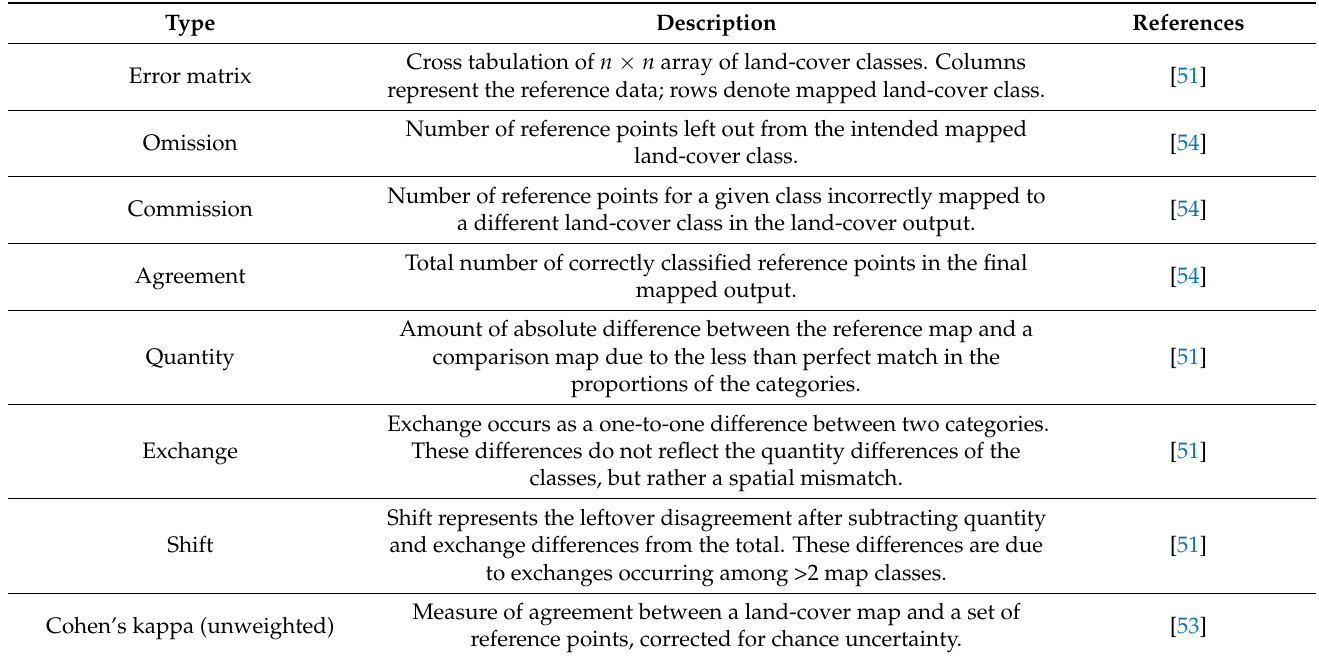
Table 1. Technique comparison agreement